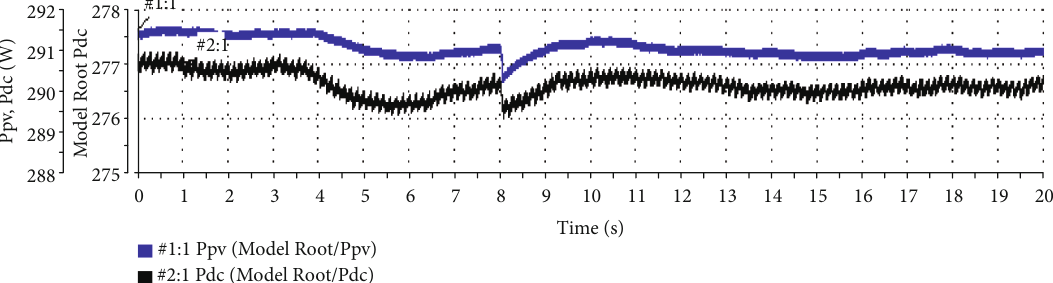
Figure 20: Steady-state power characteristics.